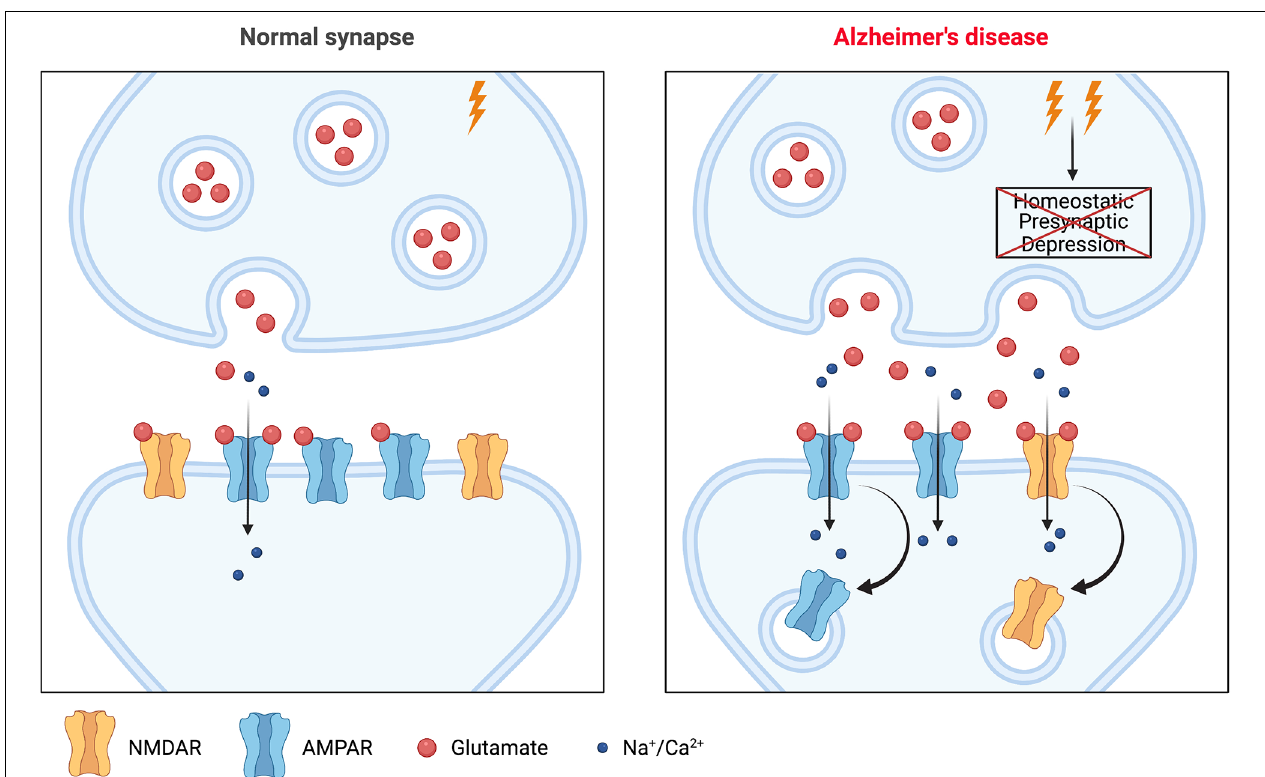
FIGURE 1 | A potential role for homeostatic synaptic plasticity (HSP) in Alzheimer’s disease (AD) pathogenesis. The left panel shows a glutamatergic synapse under normal physiological conditions. The right panel shows a synapse during the early stages of AD. There is enhanced synaptic activity in affected networks, with increased synaptic glutamate release. This would normally be compensated by one or more mechanisms of HSP but if these fail, as many appear to in the context of AD, then elevated synaptic release persists and can drive a downregulation of postsynaptic strength via various mechanisms including postsynaptic mechanisms of HSP that remain intact, or potentially even recruitment of Hebbian plasticity (LTD). This internalization of glutamate receptors (AMPAR/NMDAR) could alter the ability of the synapse to support (further) Hebbian plasticity, with resultant effects on learning and cognition. Image created with Biorender.com. LTD, long term